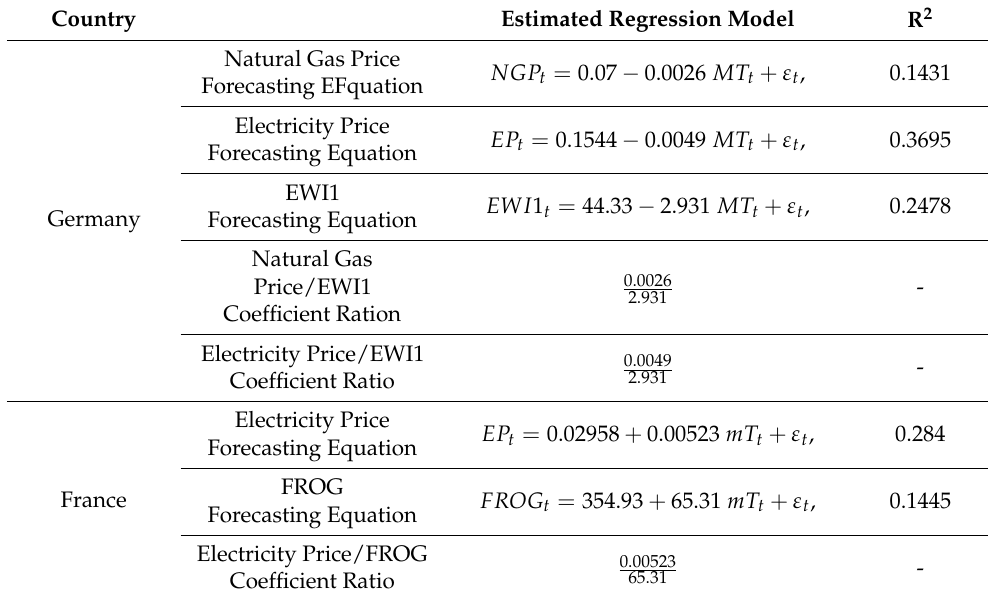
Table 2. Estimated forecasting models for hedging energy price